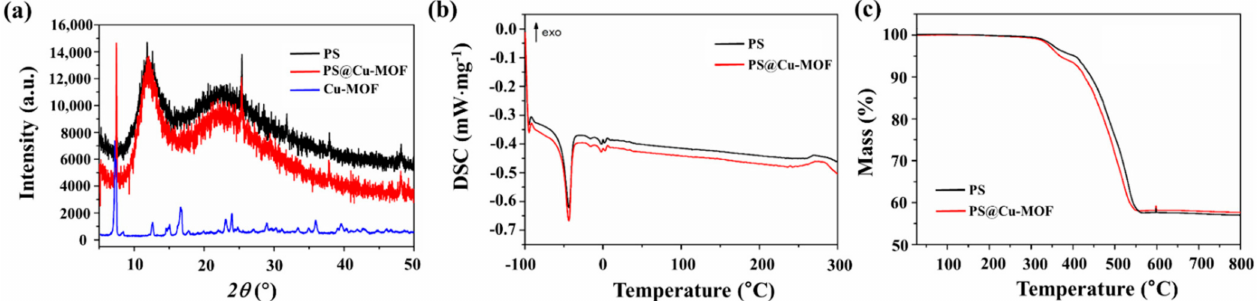
Figure 2. Characterization of PS and PS@Cu-MOF; ( a ) PXRD patterns, ( b ) DSC scans, and ( c ) TGA